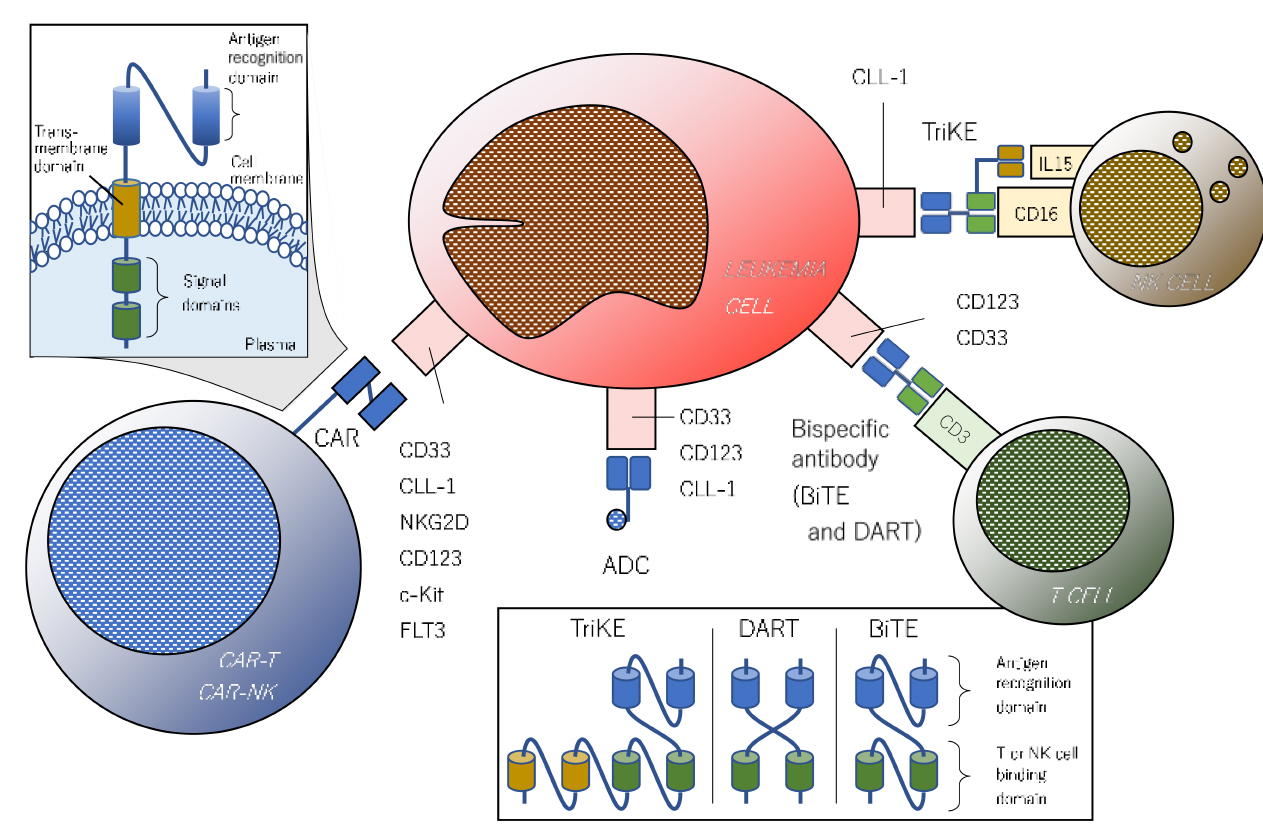
Figure 2. Potential immune targets being investigated in preclinical and early-phase trials. CAR consists of an antigen- recognizing extracellular domain and an intracellular signal domain(s). CAR-T or natural killer-targeting CD33, CLL-1, and pan-cancer antigen NKG2D have been evaluated in phase I trials. While bispecific T-cell engager (BiTE) and trispecific killer cell engager (TriKE) are composed of a single-chain variable fragment (scFv), dual-affinity retargeting (DART) is composed of two cross-linked variable fragments. Bispecific antibodies (BiTEs and DARTs) targeting CD33 and CD123 have been tested in early-phase trials. Gemtuzumab ozogamicin (GO), a CD33-directed antibody-drug conjugate, has already been used in clinical